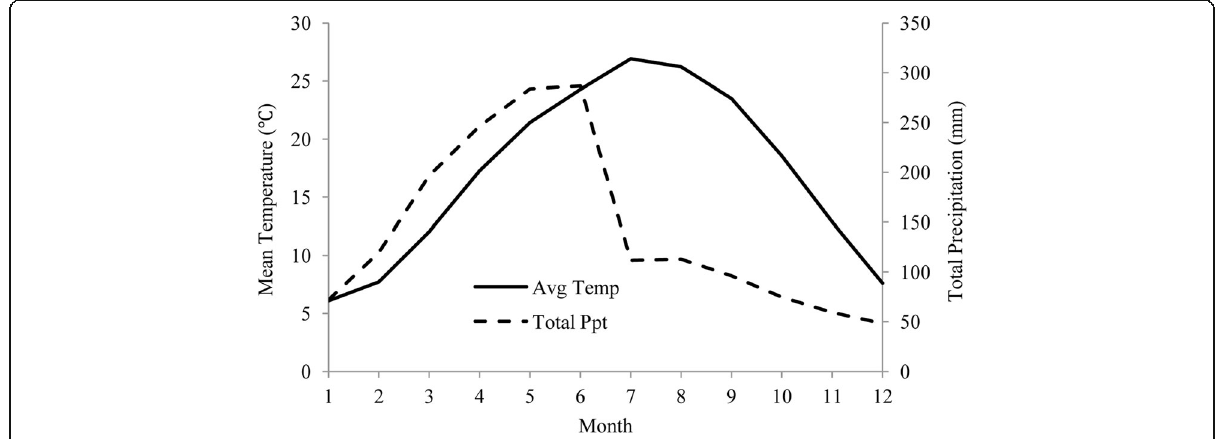
Fig. 4 Average monthly temperature and precipitation calculated with data from the Fujian climate station, years 1961 –